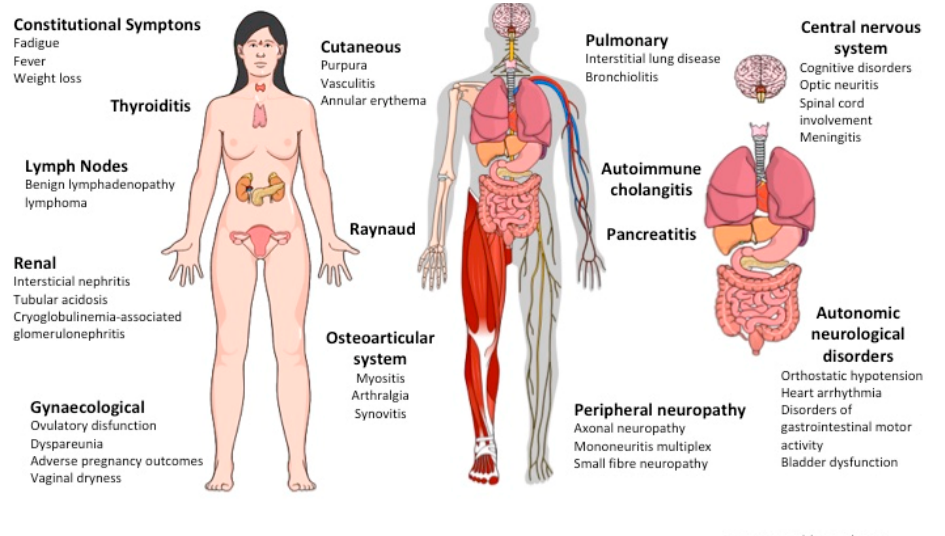
Figure 1. Extraglandular manifestations of Sjogren’s Syndrome. The pleiotropic features of systemic multiorgan involvement in SS are not well-understood. Some of the extraglandular manifestations may arise from immune-complex deposition in the context of cryoglobulinemia. Other symptoms and signs are related to lymphoproliferation, dendritic cell activation, and cytokine maintenance of the inflammatory process. Interferon- γ -inducible-Kynurenine Pathway could play a role in the neural manifestations, fatigue and chronic pain [16]. Figures were obtained from the free version of myndthegraph.com.